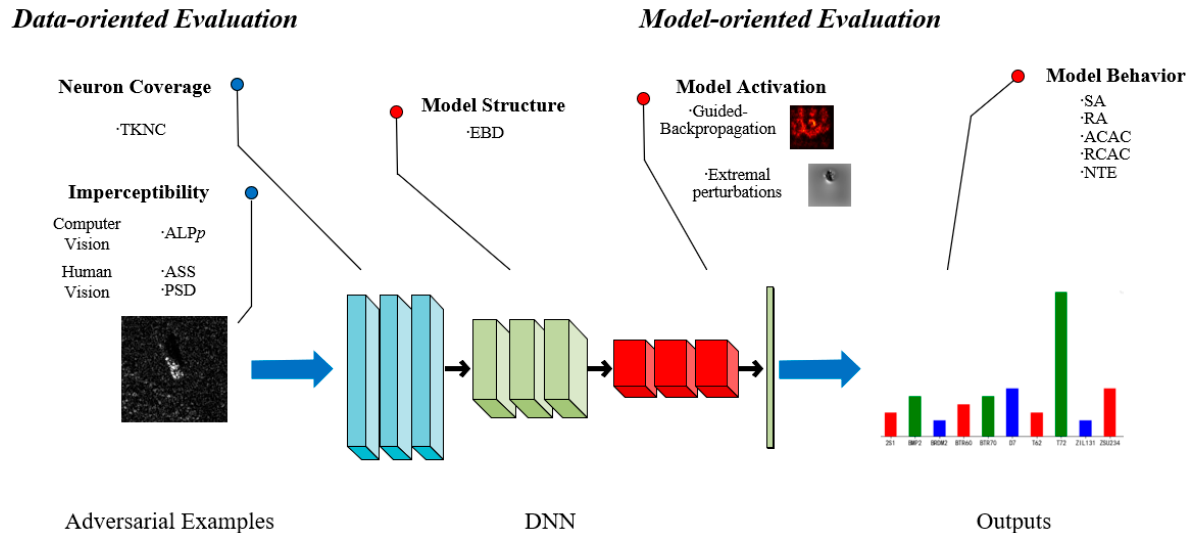
Figure 2. With 11 evaluation methods in total, our comprehensive robustness evaluation framework focuses on data and model, which are the key factors in an adversarial setting.